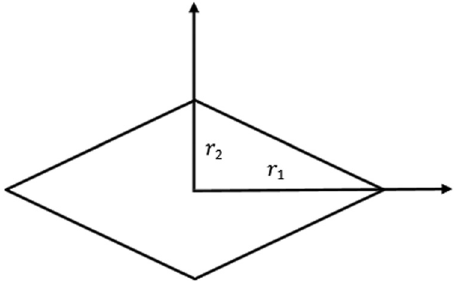
Figure 3. Figure 1: 2D rhombus.